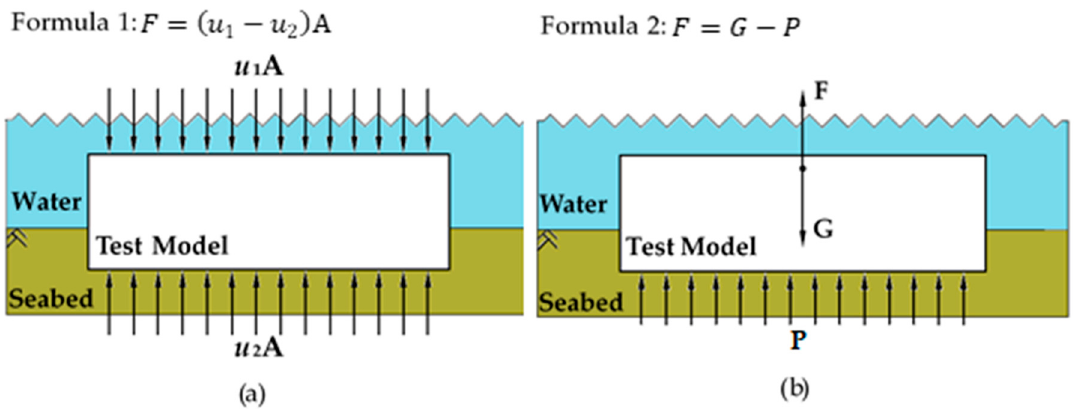
Figure 3. Schematic diagram of the test principle for ( a ) Formula 1 and ( b ) Formula 2.